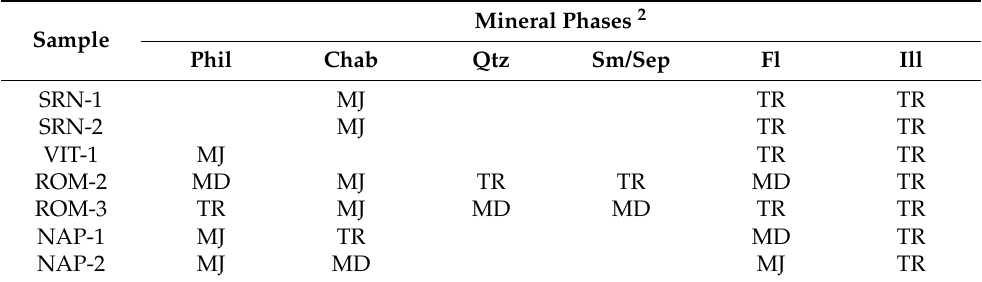
Table 1. Results of the XRD mineralogical analysis of the zeolite tuff samples 1 .